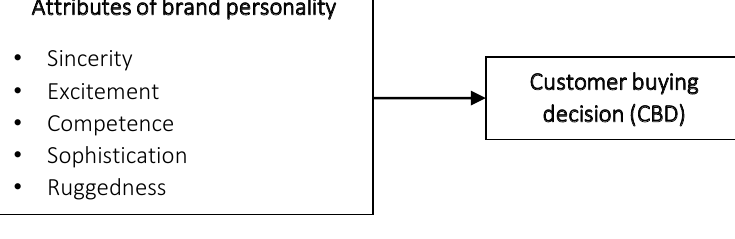
Figure 1. Conceptual